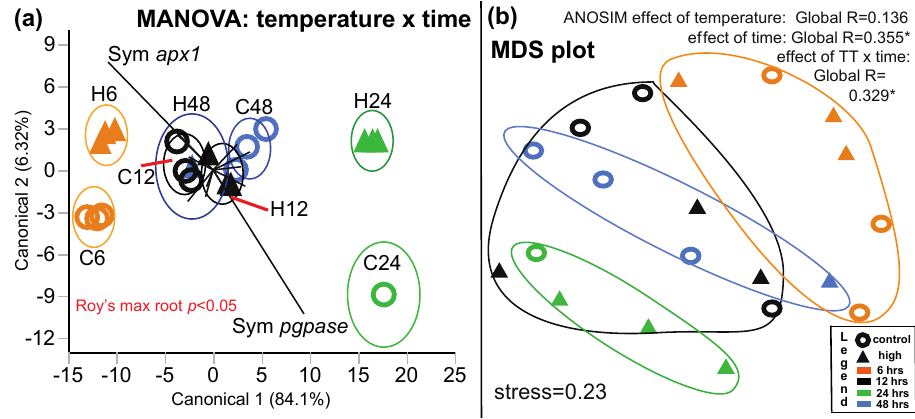
Figure 3. Multivariate analysis of variance (MANOVA) and multidimensional scaling (MDS) analysis of the Seriatopora hystrix short-term temperature experiment (SHSTTE). MANOVA was used to test for differences between the eight temperature × time groups ( a ), and 4 of the 24 total samples were omitted due to missing data points (see Figure 1.); therefore, Roy’s max root, rather than Wilks’ lambda, was calculated in ( a ). In ( a ), the control-12-h (C12) and high temperature-12-h (H12) centroids (black circles; 95% confidence intervals for these and all centroids presented in this manuscript) lie within the high temperature-48-h (H48; blue circle) centroid and have been labeled with red lines. Not all axes have been presented or labeled due to spatial constraints. MDS analysis of the same 20 samples with PRIMER ( b ). In this panel only, circles were drawn by hand and do not represent 95% confidence centroids. The legend for both panels lies in the lower-right corner of ( b ). * p < 0.05. TT = temperature treatment.